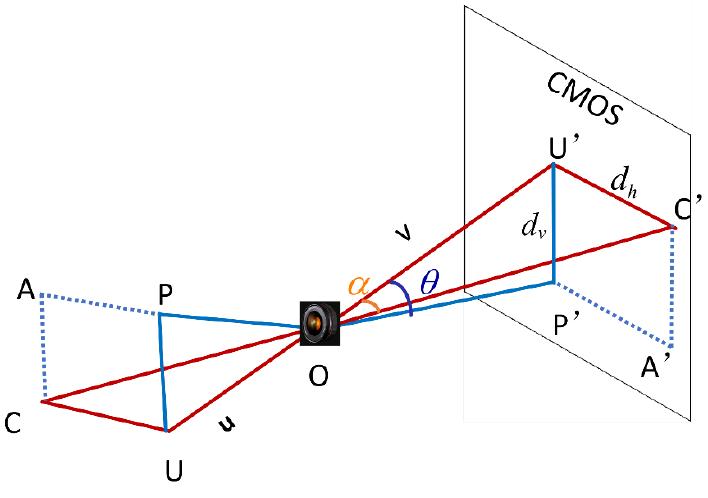
Figure 4. The monocular vision-based angulation model.